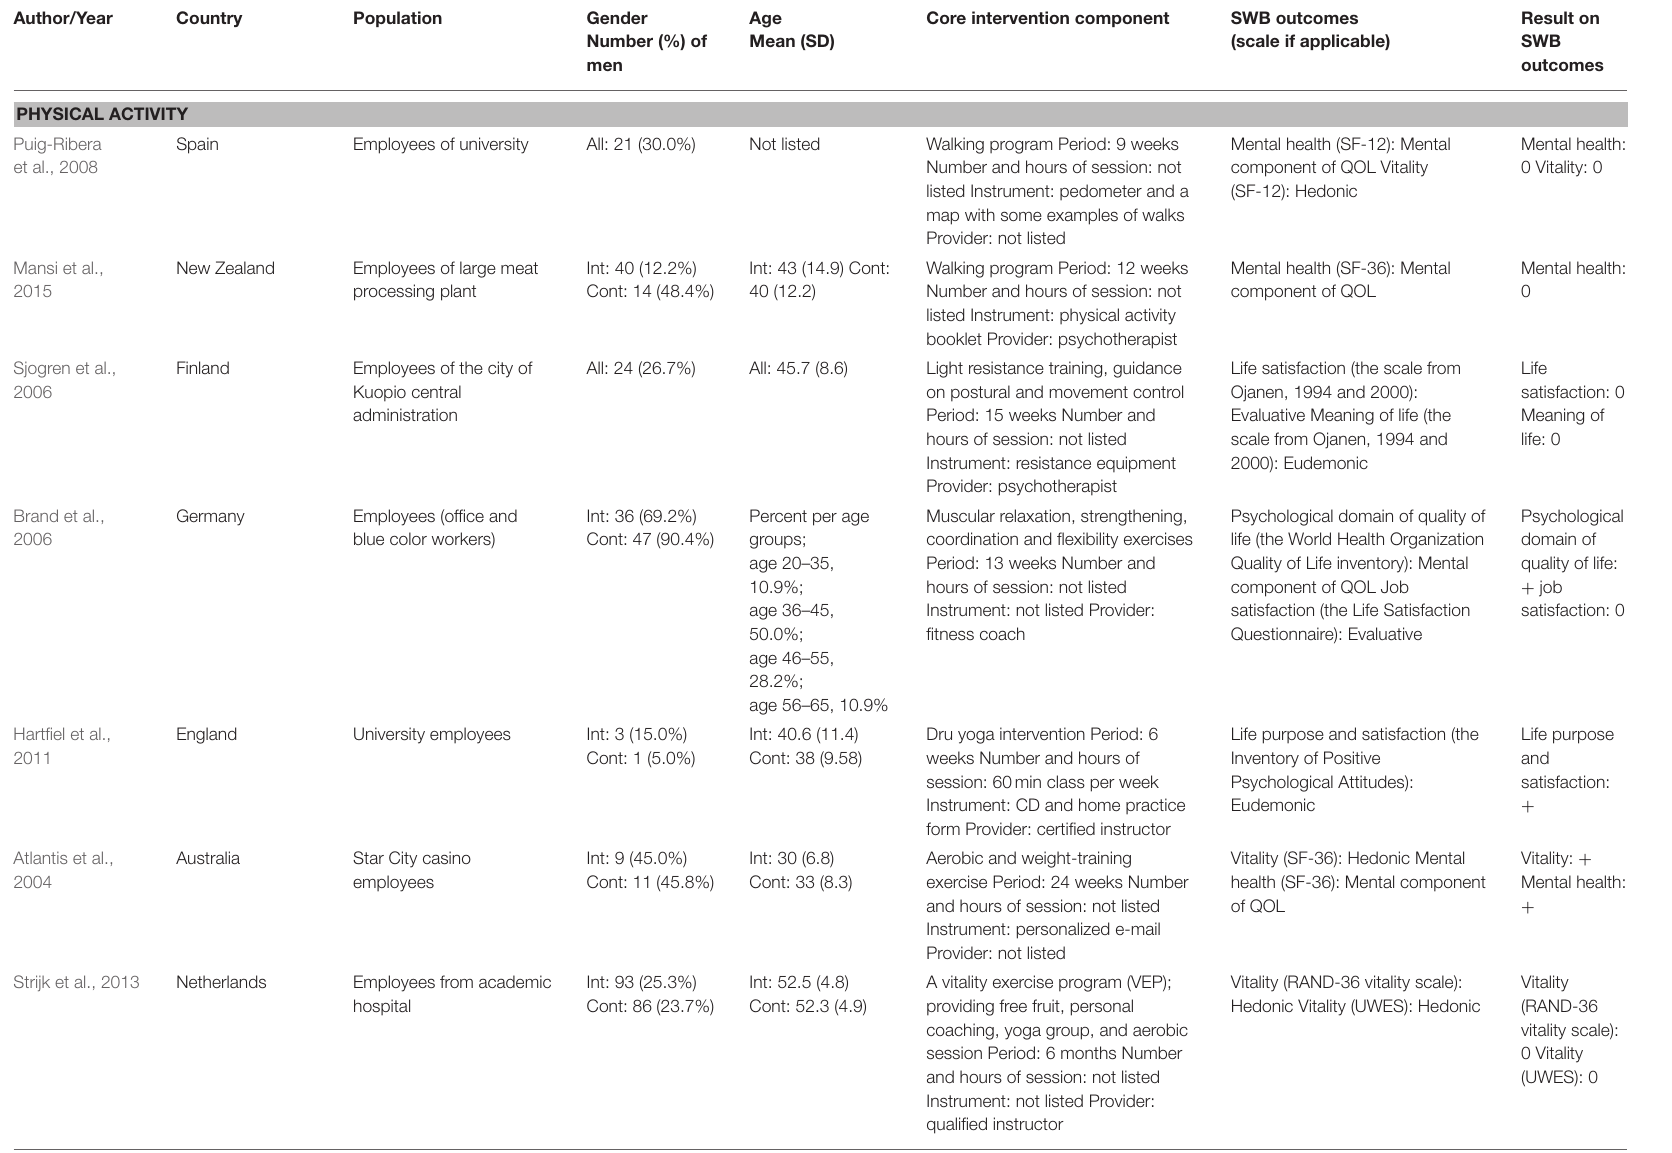
TABLE 1 | The characteristics of the studies included in the systematic reviews ( N =